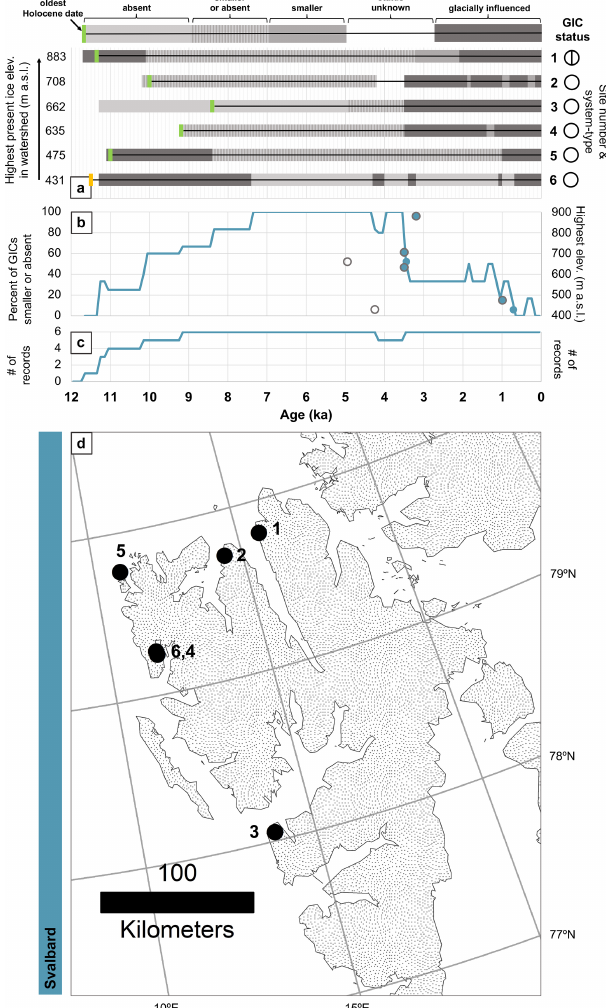
Figure 8. Holocene lake-based GIC records from Svalbard. Panel descriptions, symbols, and colors are the same as in Fig. 3. Sites are as follows: 1. Allaart et al. (2021) (Lake Femmilsjøen, NW Åsgardfonna Ice Cap); 2. Røthe et al. (2018) (Lake Vårfluesjøen, Bybreen, Uglebreen, Salomonbreen, and Grennabreen); 3. Svend- sen and Mangerud (1997) (Lake Linnèvatnet, east basin, Lin- nèbreen); 4. Røthe et al. (2015) (Kløsa Lake, Karlbreen); 5. de Wet et al. (2018) (Lake Gjøavatnet, Annabreen); 6. van der Bilt et al. (2015) (Lake Hajeren, North and South glaciers). The oldest ages reported in Allaart et al. (2021) are marine. We show the oldest age reported in the lacustrine section of the